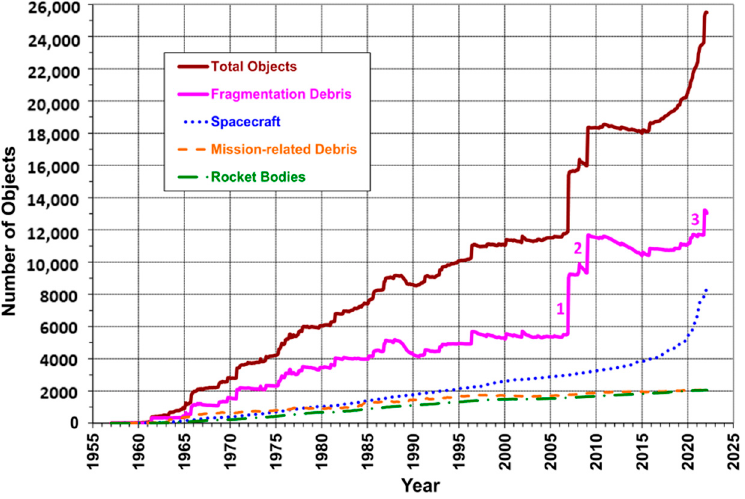
Figure 7. Growth trend in the number of space objects.